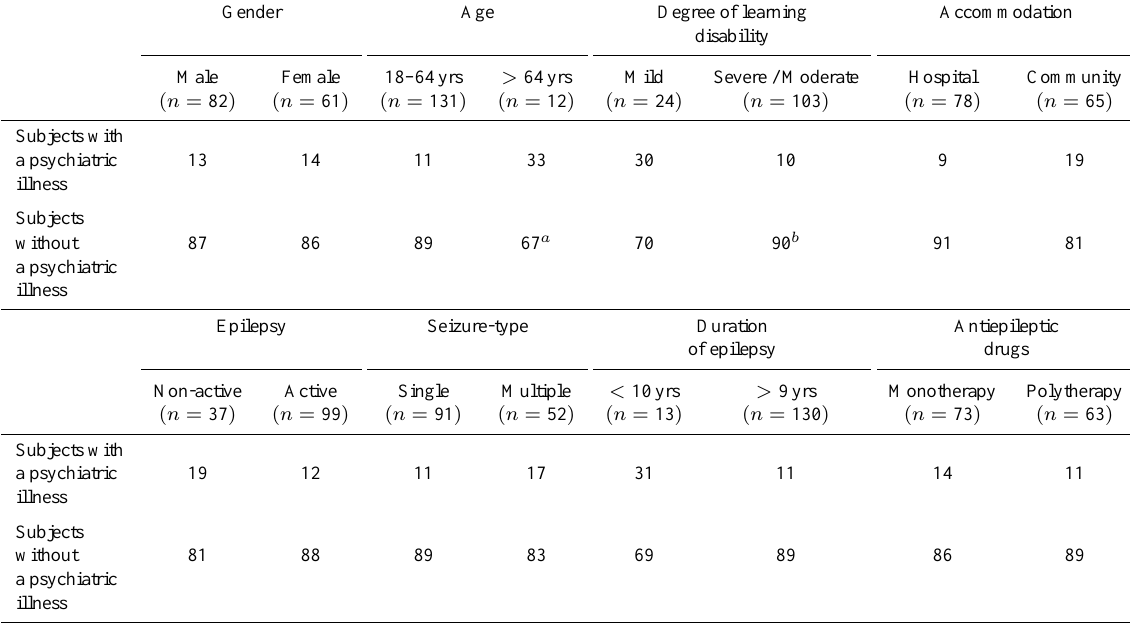
Table 2 Percentage of subjects with or without a psychiatric illness in different subgroups of the